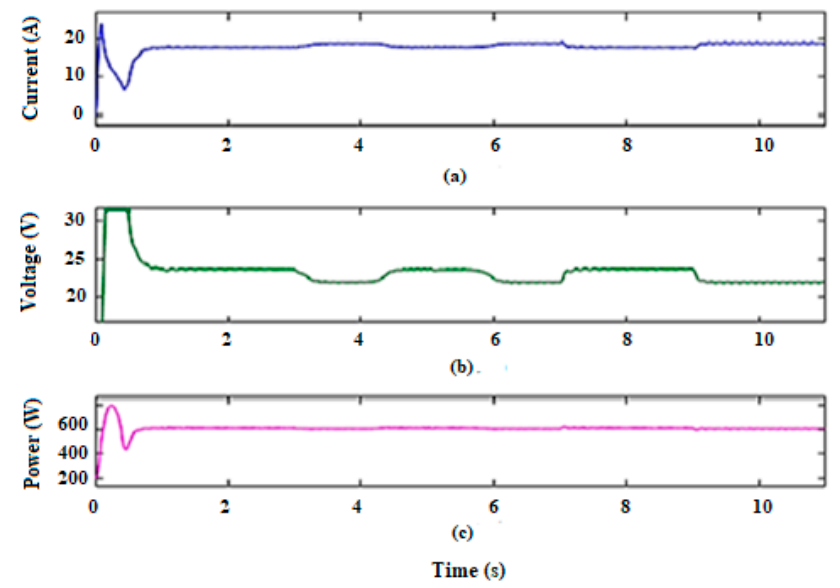
Figure 13. The DC bus output current ( a ), voltage ( b ), and power ( c ).